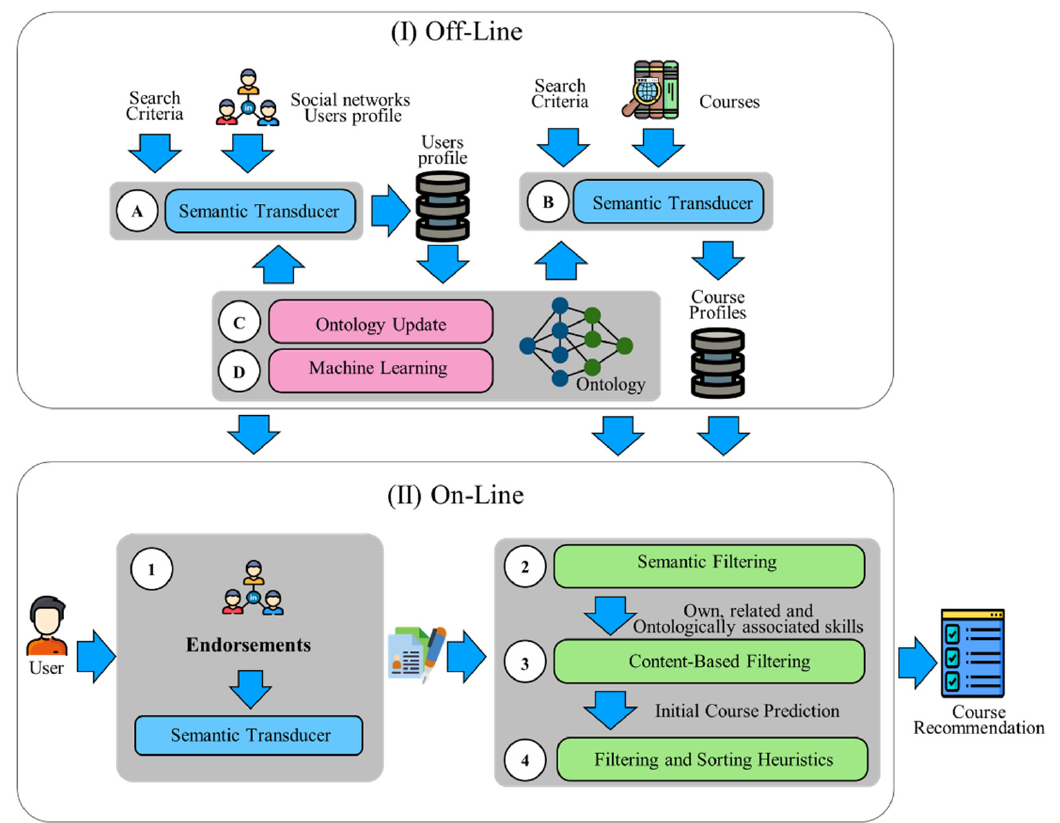
Figure 1. Hybrid RS architecture based on ontology and ML with endorsements.